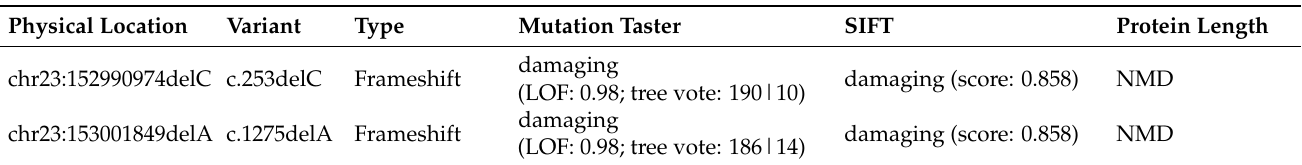
Table 2. Novel single nucleotide deletions in the ABCD1 gene identified in this study and the results of the in silico prediction